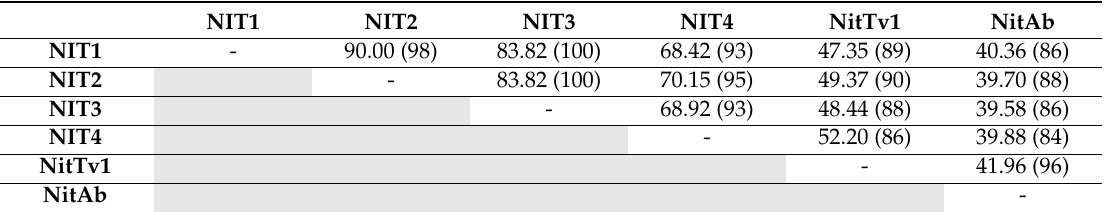
Table 1. Amino acid sequence identities (%) of plant nitrilases NIT1–NIT4 from Arabidopsis thaliana and their fungal homologues NitTv1 from Trametes versicolor and NitAb from Agaricus bisporus var. bisporus (sequence coverage (%) in